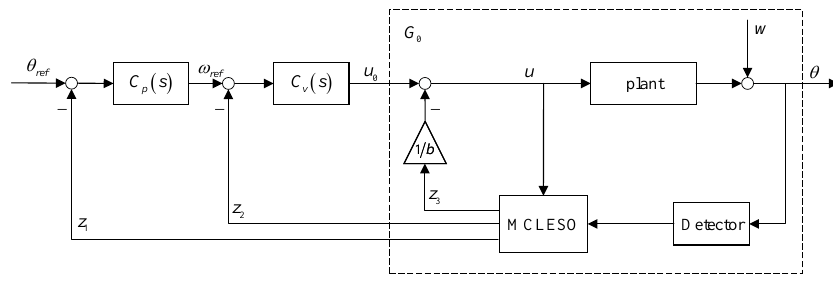
Figure 7. The block diagram of the VDFC with